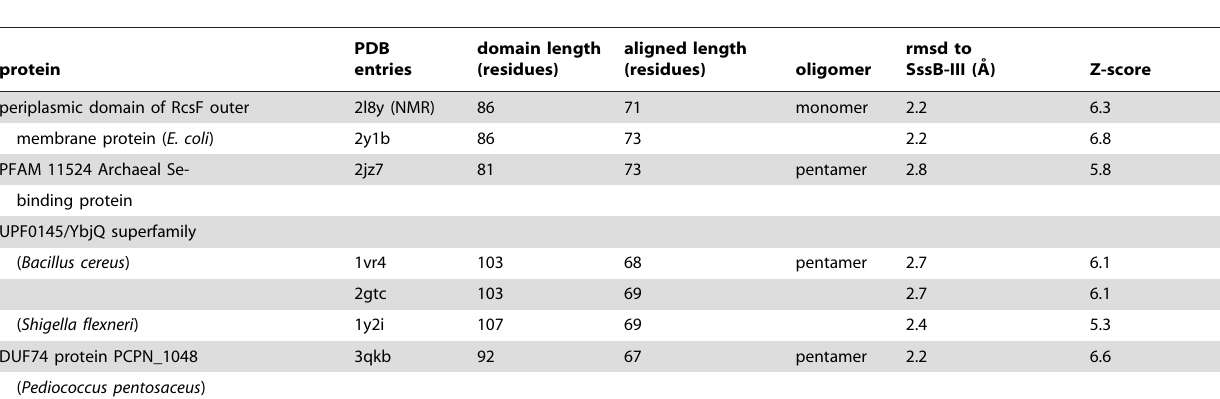
Table 4. Protein structures from the Protein Data Bank that are similar (Z score . 5.0) to DUF1471 proteins, determined with Dali [20]. Structures are X-ray structures except as